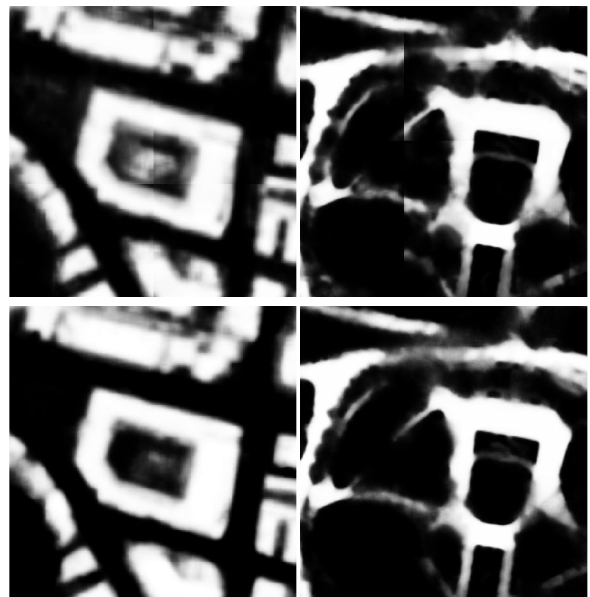
Figure 13. Extract of predictions for building class (left column) and asphalt (right column) with edge clipping (middle row) and smooth blending (bottom row) Vectorized land cover map: Figure 1 shows an extract of the final product build upon predictions map from DeeplabV3+ model with BCE loss.